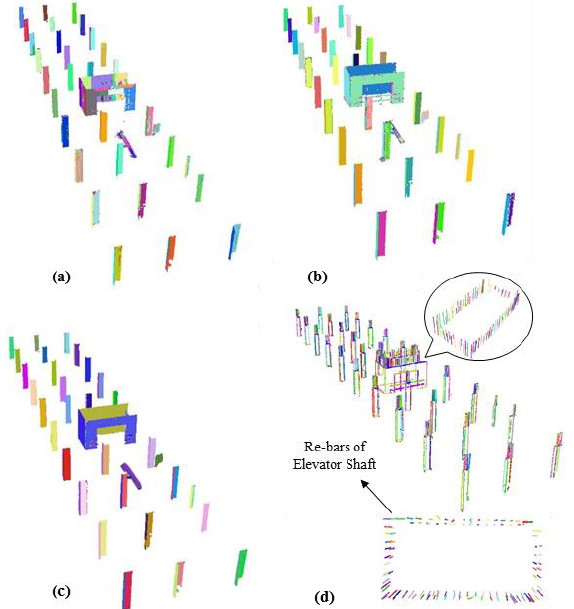
Figure 12. Planar segmentation: a) first iteration, 185 clusters; b) last iteration, 132 clusters; c) after robust complete linkage, 87 clusters. d) Linear segmentation results, 347